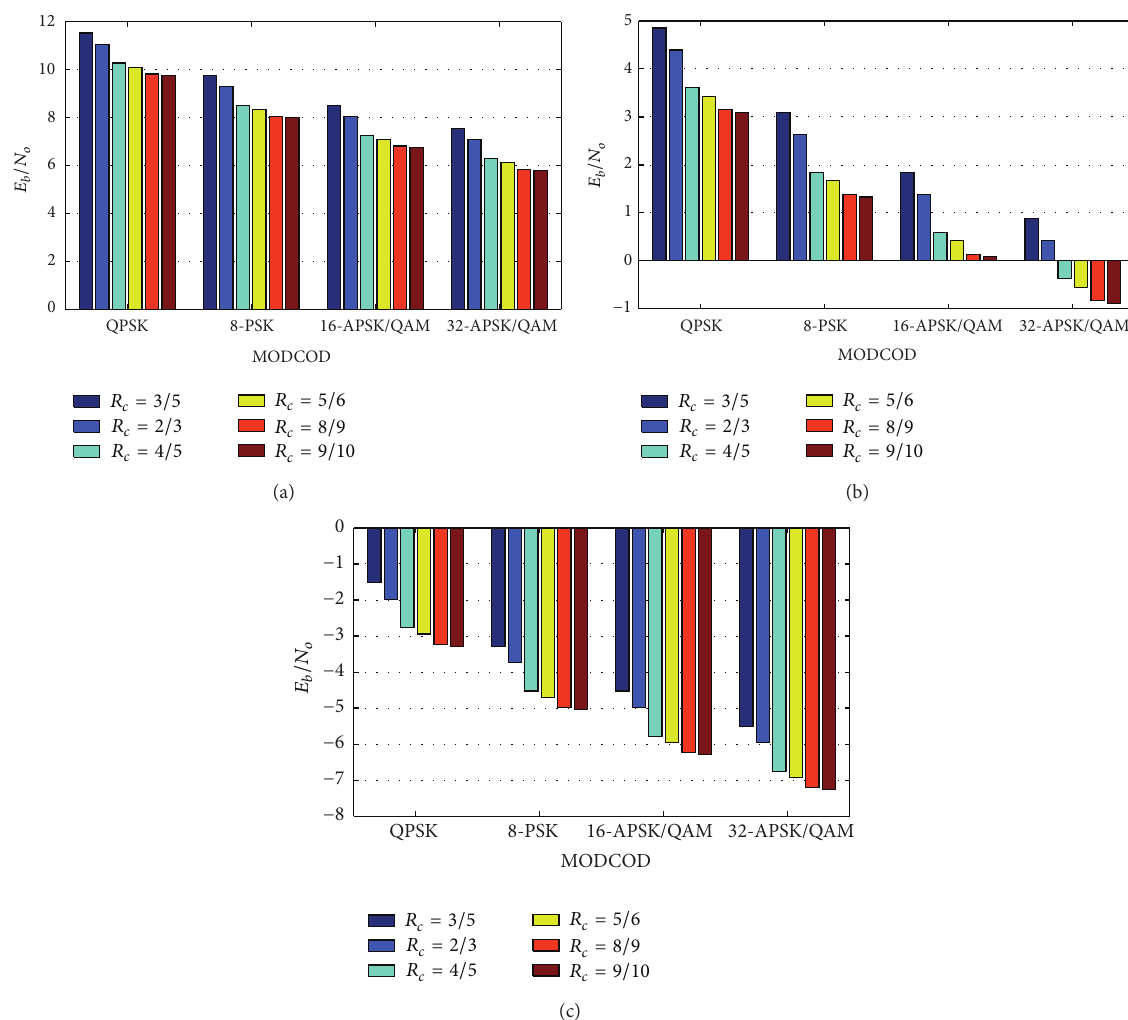
Figure 16: 𝐸 𝑏 /𝑁 𝑜 (in dB) at different MODCODs: (a) clear LOS, (b) shadowing, and (c) blockage scenarios.